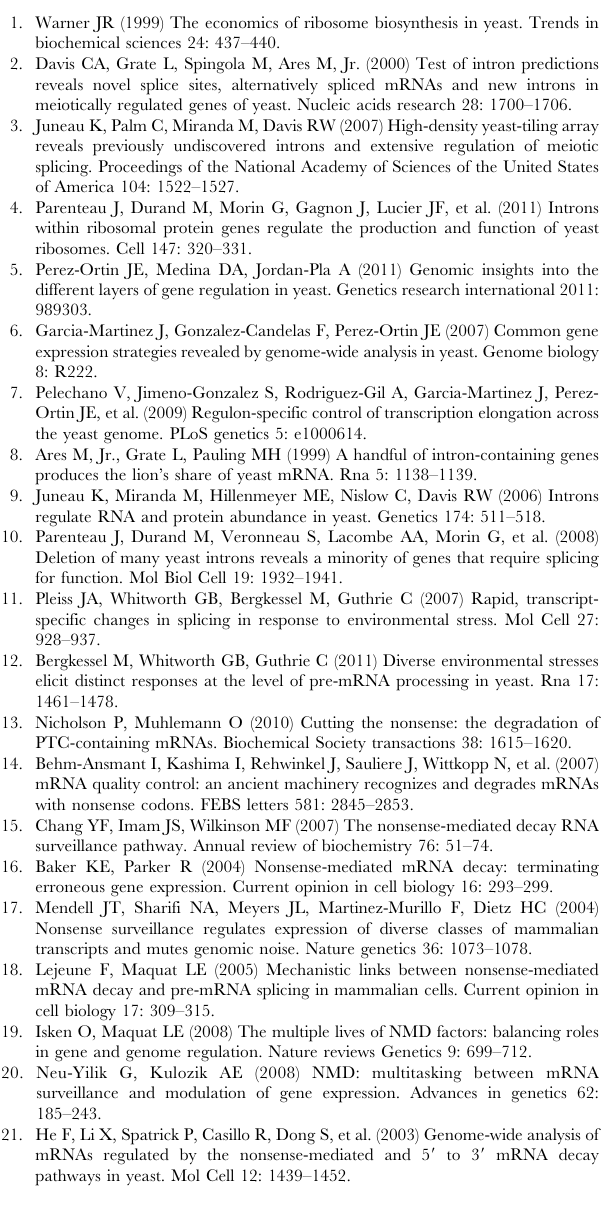
subclasses by K-means clustering using the Euclidean distance.